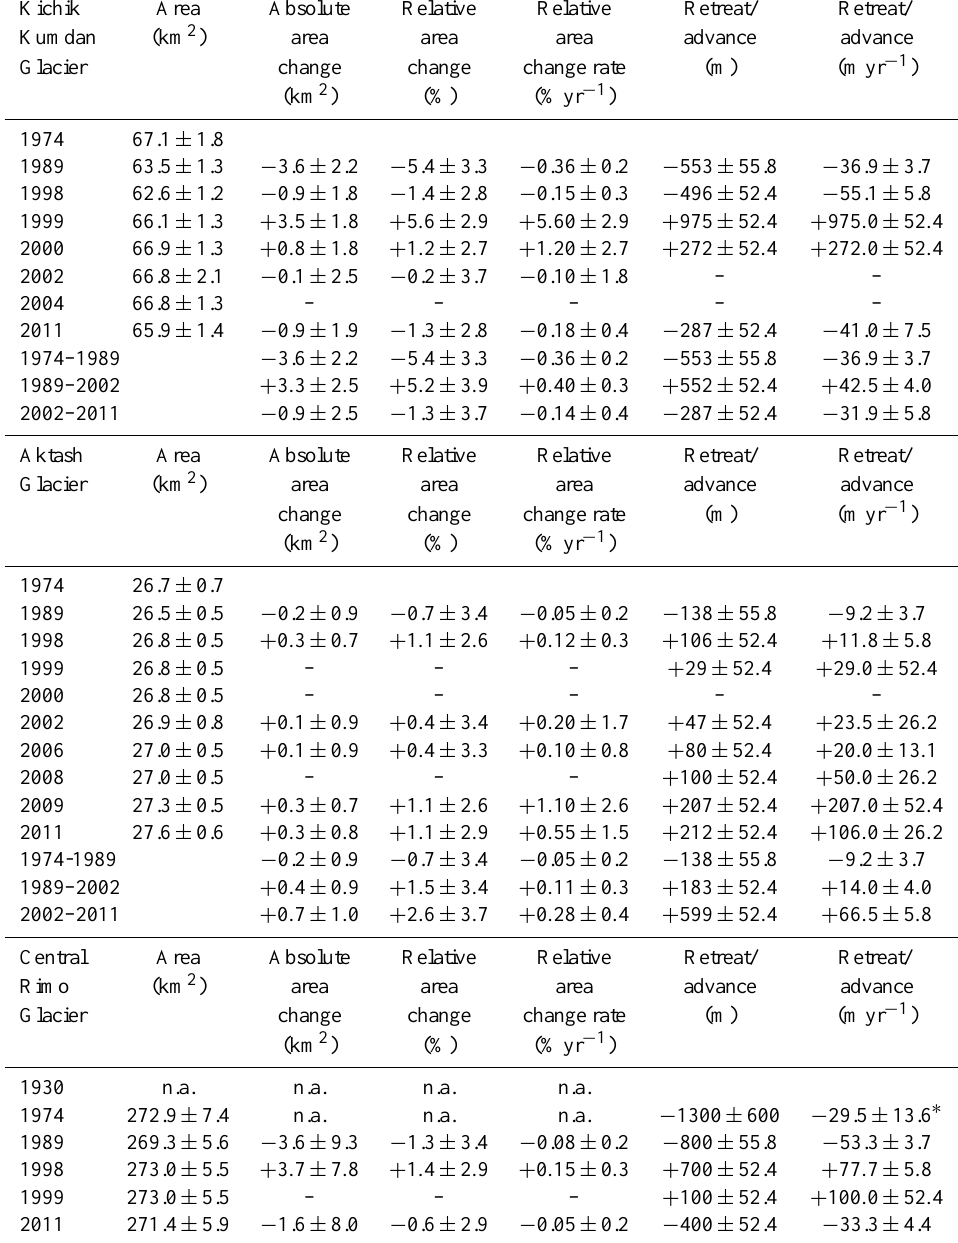
Table 4. Length and area fluctuation of Kichik Kumdan, Aktash and Rimo glaciers during study period. Kichik Area Absolute Relative Relative Retreat/ Retreat/ Kumdan (km 2 ) area area area advance advance Glacier change change